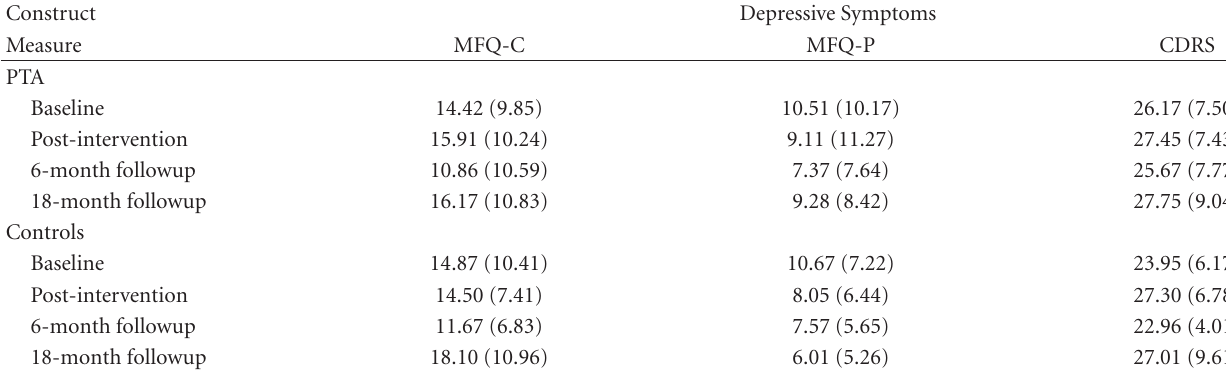
Table 3: Adjusted mean scores on depressive measures by group and time.